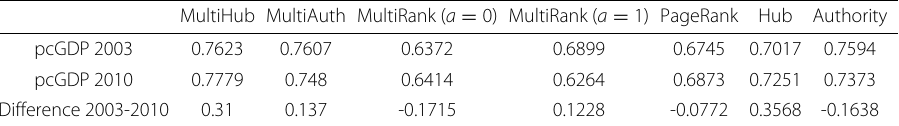
Table 3 First two lines: Spearman correlation coefficient between the rankings from pcGDP of the reference year and those obtained by different algorithms. Last line: correlation coefficient between evolution in rankings over time. First 4 columns use multilayer algorithms, last 3 use single layer algorithms on the aggregate